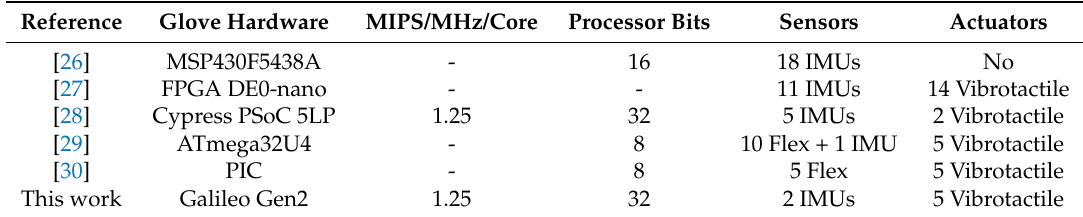
Table 1. Comparison of the hardware, sensors, and actuators used in this work with other works.